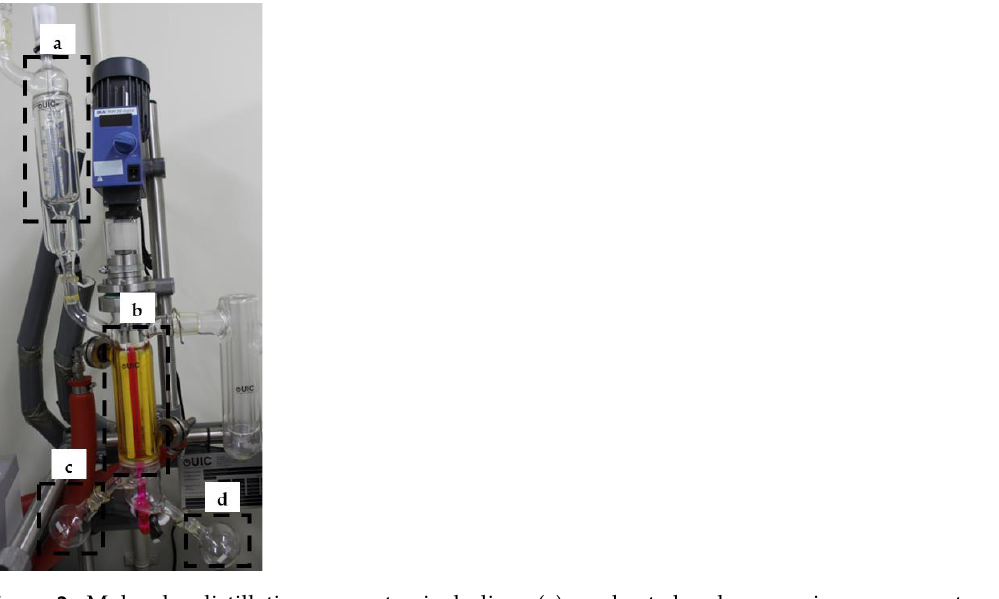
Figure 2. Molecular distillation apparatus including: ( a ) pre-heat chamber, a major component; ( b ) evaporation chamber; ( c ) collected retentate; and ( d ) collected distillate.